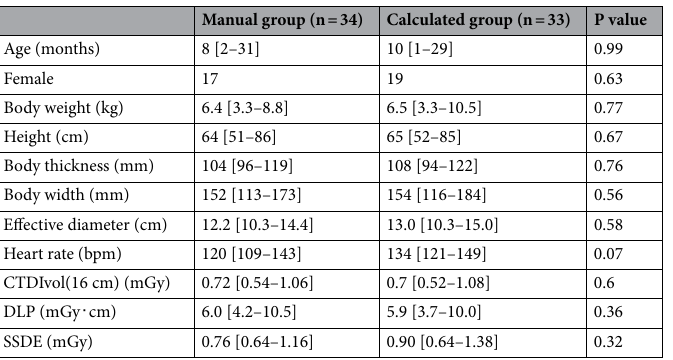
Table 1. Patient demographics. Values are n, median [interquartile range]. * indicates statistical significance. CTDIvol computed tomography dose index volume, DLP dose-length product, SSDE size-specific dose estimates